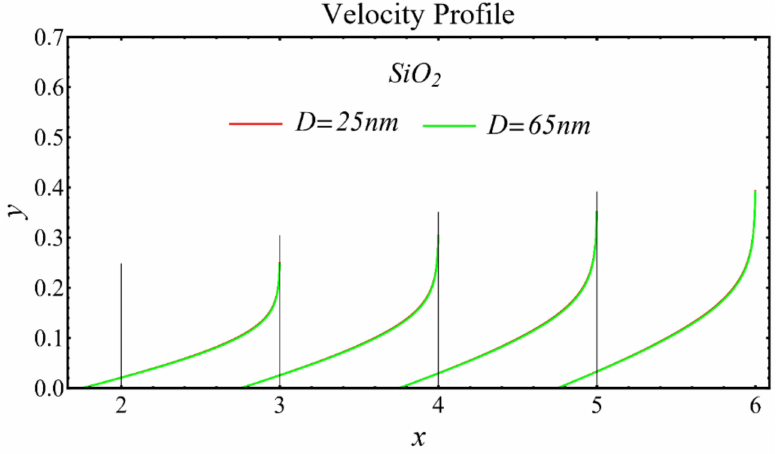
Figure 10. Velocity profile of SiO 2 -EG nanofluid under influence of nanoparticle